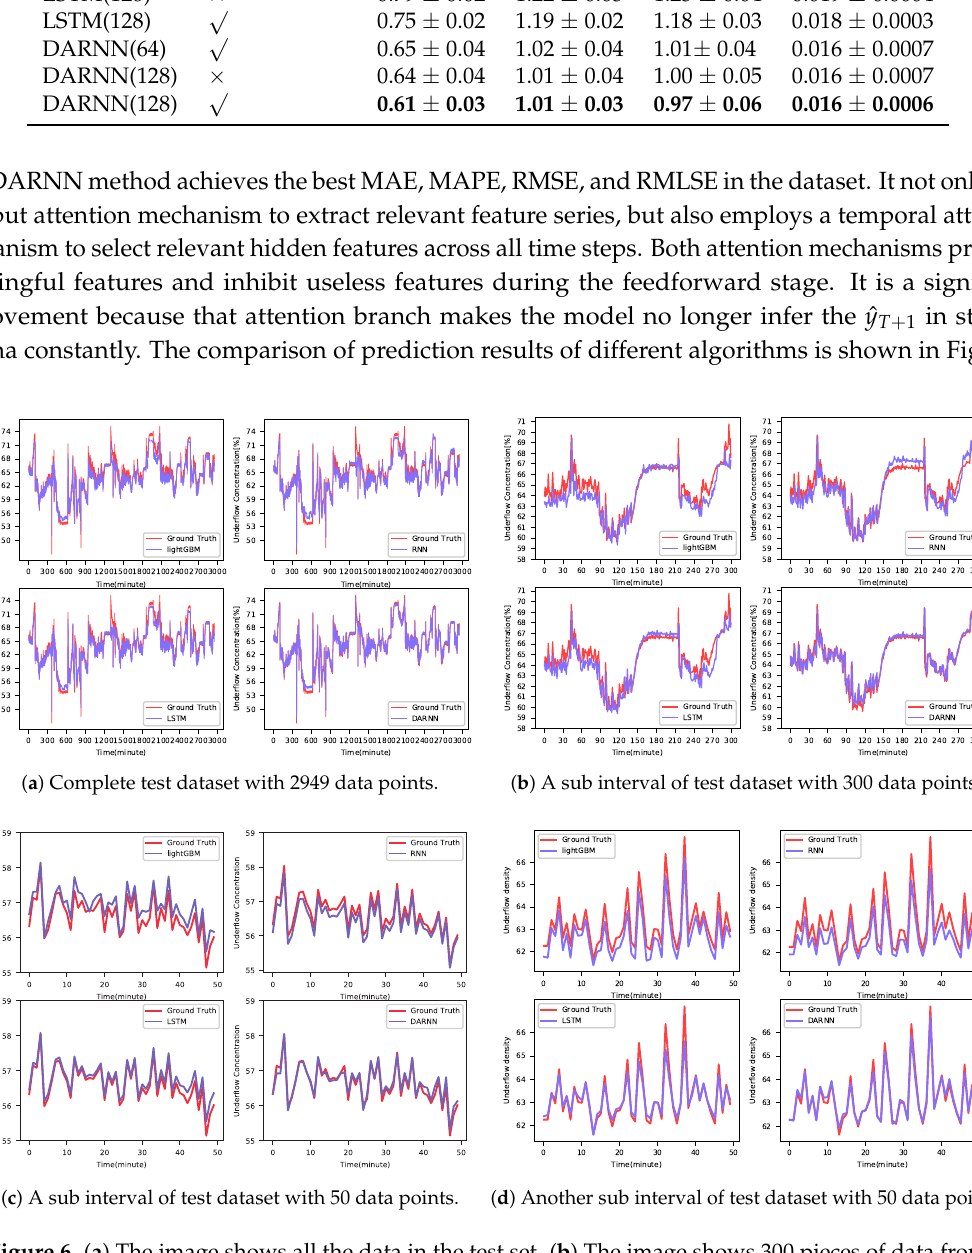
Table 6. Time series prediction results over our Dataset (best performance displayed in boldface). The size of encoder hidden states m and decoder hidden states p are set as m = p = 64 and 128. Modles Enhancement MAE RMSE MAPE RMLSE √ LightGBM 0.83 1.26 1.27 0.020 √ RNN(64) 0.86 ± 0.06 1.28 ± 0.05 1.34 ± 0.09 0.020 ± 0.0008 √ RNN(128) 0.78 ± 0.03 1.22 ± 0.02 1.23 ± 0.03 0.019 ± 0.0005 √ LSTM(64) 0.81 ± 0.04 1.24 ± 0.04 1.27 ± 0.06 0.019 ± 0.0005 LSTM(128) × 0.79 ± 0.02 1.22 ± 0.03 1.23 ± 0.04 0.019 ± 0.0004 √ LSTM(128) 0.75 ± 0.02 1.19 ± 0.02 1.18 ± 0.03 0.018 ± 0.0003 √ DARNN(64) 0.65 ± 0.04 1.02 ± 0.04 1.01 ± 0.04 0.016 ± 0.0007 DARNN(128) × 0.64 ± 0.04 1.01 ± 0.04 1.00 ± 0.05 0.016 ± 0.0007 √ 0.61 ± 0.03 1.01 ± 0.03 0.97 ± 0.06 0.016 ± 0.0006 DARNN(128)